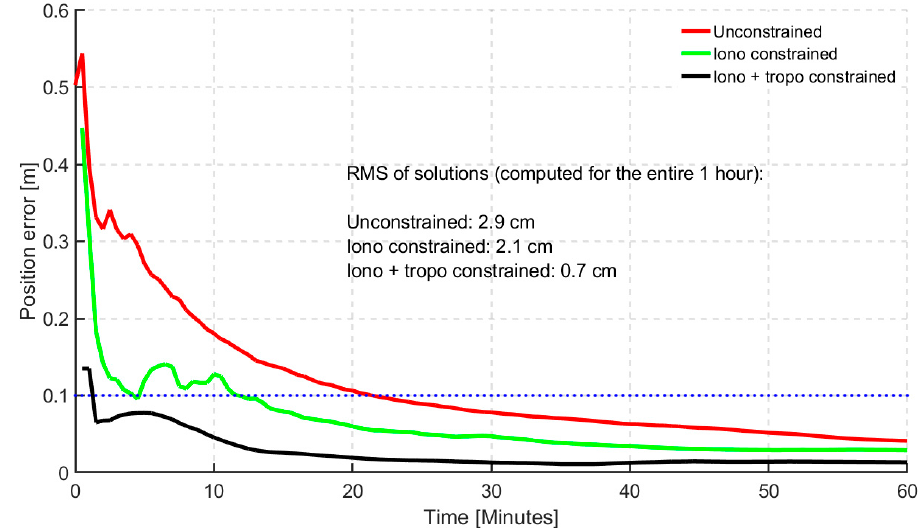
Figure 9. 95th percentile time series showing horizontal positional error (hourly) based on 24 hourly solutions for 40 stations for triple-frequency GREC processing mode. Blue dotted line represents the 10 cm convergence threshold.